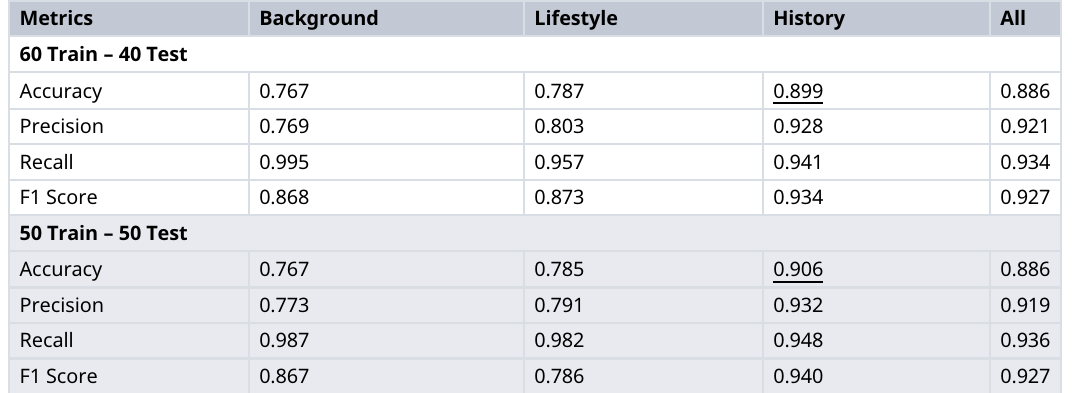
Table 10. MLP (Binary levels).